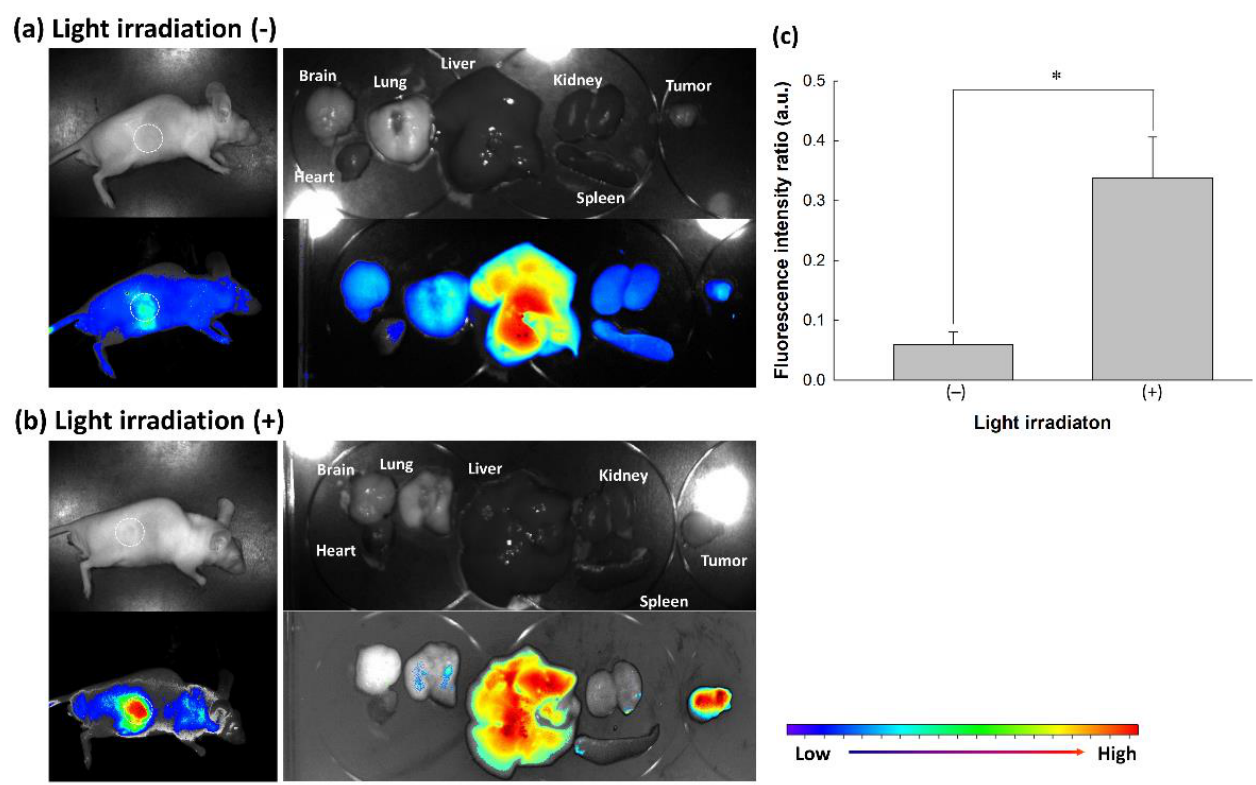
Figure 10. Animal tumor imaging of tumor xenograft model. Tumor xenograft model of HeLa cells were prepared in the back of nude BALb/C mice. Nanophotosensitizer solution was i.v. adminis- tered through tail vein (Injection volume: 100 µL; dose, 10 mg/kg as a Ce6 concentration). On the 3 h and 6 h after the drug injection, one mouse was exposed to light irradiation at 664 nm with 5.0 J/cm 2 using an expanded homogenous beam. Another one was also placed on the field of light irra- diation with shielding of tumor mass to avoid light irradiation. Nine hours after the drug injection, mice were sacrificed and observed. Animal tumor xenograft ( a ) without light irradiation and ( b ) with light irradiation. ( c ) Comparison of fluorescence intensity between tumor and liver. Fluores- cence intensity between tumor and liver was calculated from three mouse and expressed as mean ± S.D. Fluorescence intensity ratio (arbitrary units) = fluorescence intensity of tumor/fluorescence in- tensity of liver. *, p < 0.01.